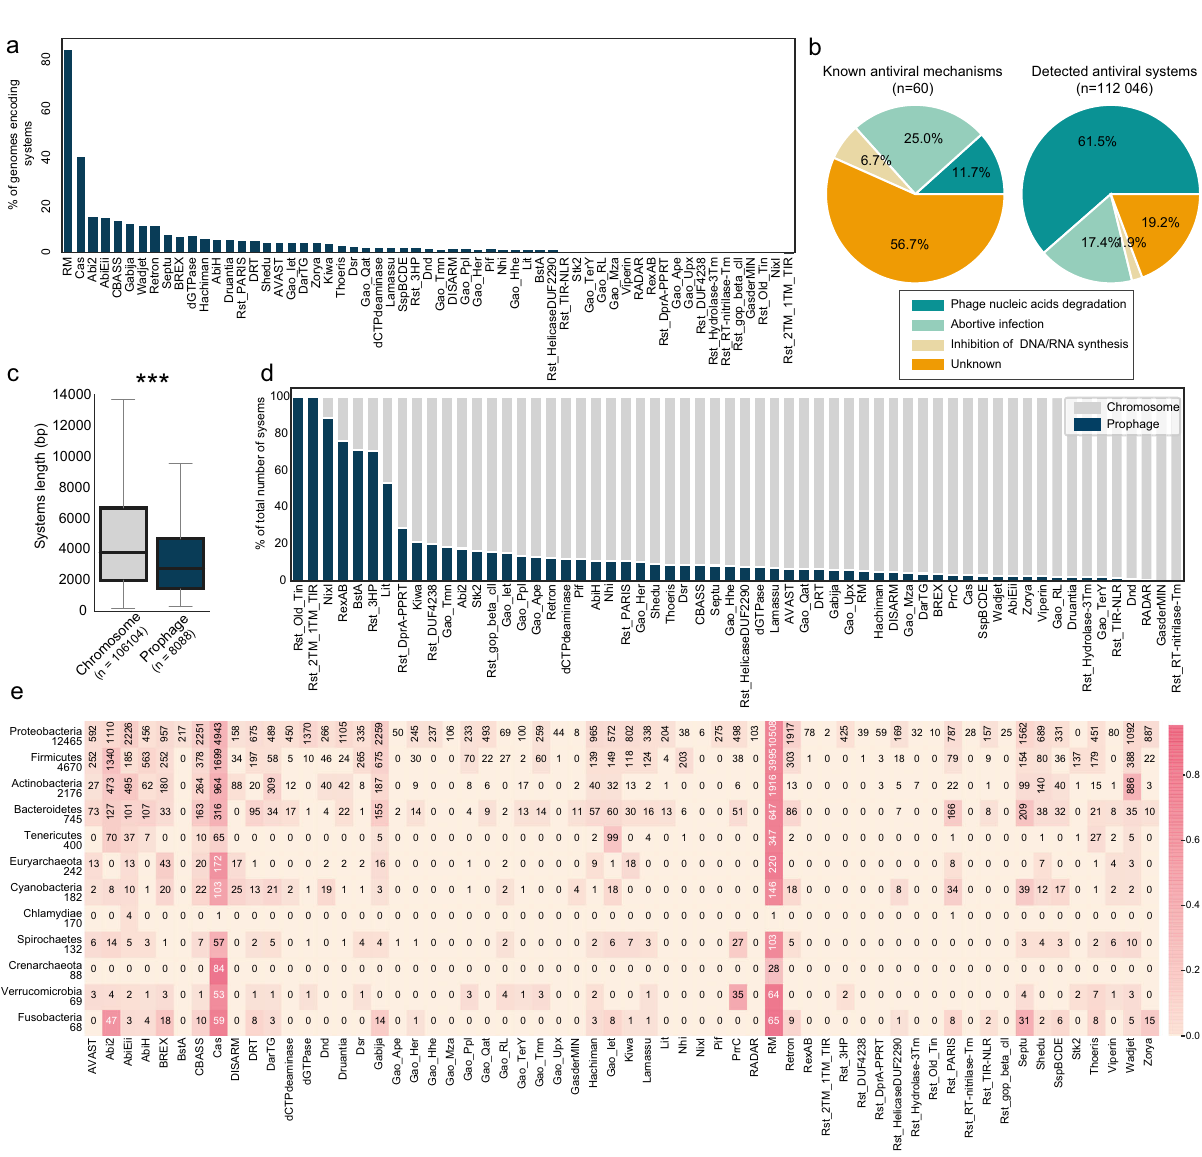
Fig. 3 Families of antiviral systems have a heterogenous distribution. a Frequency of systems in genomes. b Classi fi cation of antiviral mechanisms and detected operons according to their molecular functioning. c System length according to genomic location (***, two sided Wilcoxon test p -value = 6.5e − 273)). The box extends from the fi rst quartile (Q1) to the third quartile (Q3) of the data, with a line at the median. The whiskers extend from the box by 1.5× the inter- quartile range (IQR). n chromosome = 106,104, n prophage = 8088. Plasmids were excluded from this analysis. A system was deemed to be part of a prophage when the fi rst and last protein of the system was inside the prophage boundary. The size of a system was computed as the difference between the end of the last protein and the beginning of fi rst protein. d Frequency of genomic location for each system. e Number of systems per prokaryotic phylum. Only phyla with more than 50 genomes are represented. The number of genomes in the dataset is represented under each phylum ’ s name. The heatmap represents the frequency of each system in a given phylum (per line), color legend on the right. Absolute numbers of genomes encoding a given system is indicated in each